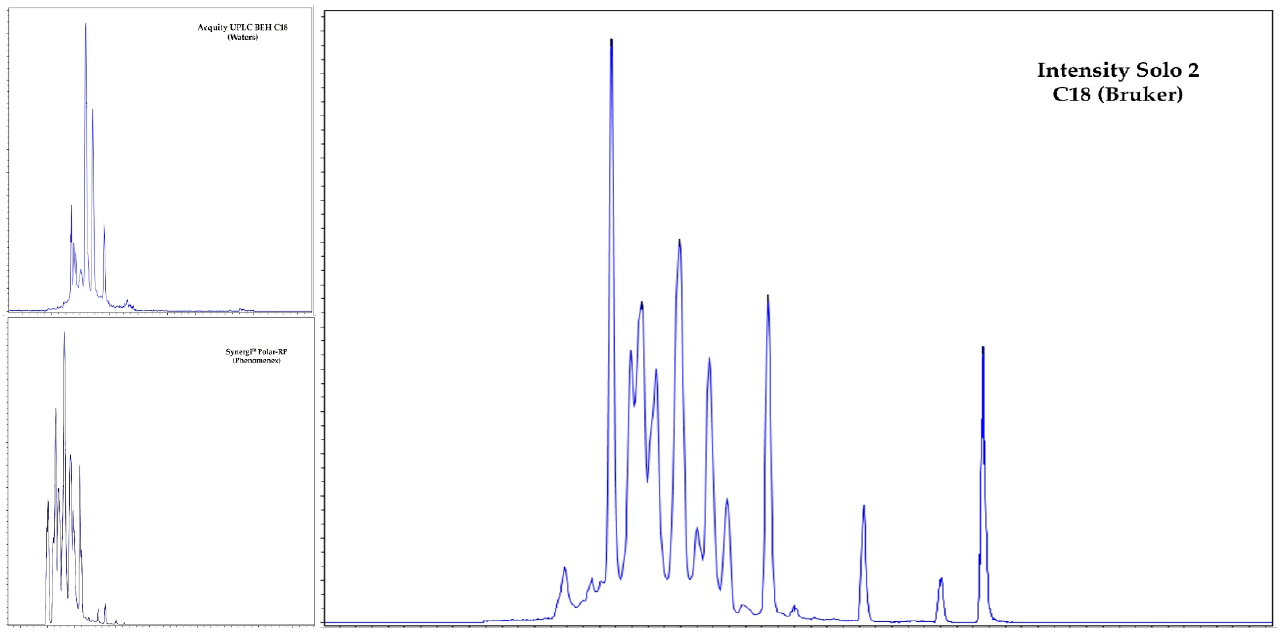
Figure 1. Total ion chromatograms (TICs) of the selected pharmaceuticals separated on different HPLC columns. Table 2. Matrix effects, RSD matrix effects (RSD ME ), precision under repeatability (RSDr) and reproducibility (RSDR) conditions, trueness, and correlation coefficient (R 2 ) achieved at different concentrations for each